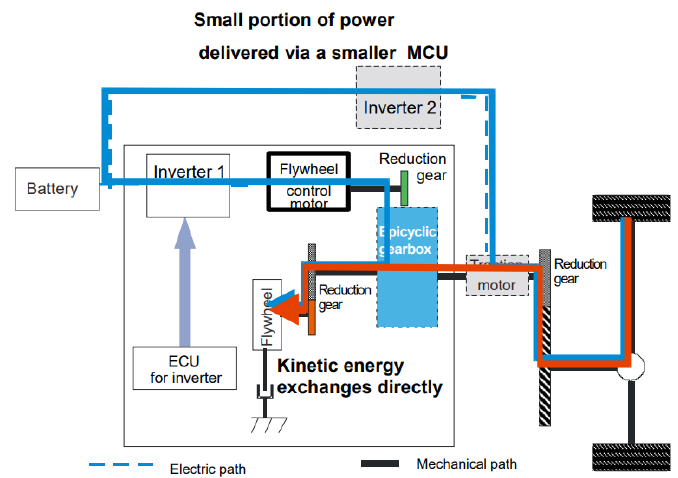
Figure 2. System topology of the flywheel power system i-KERD.